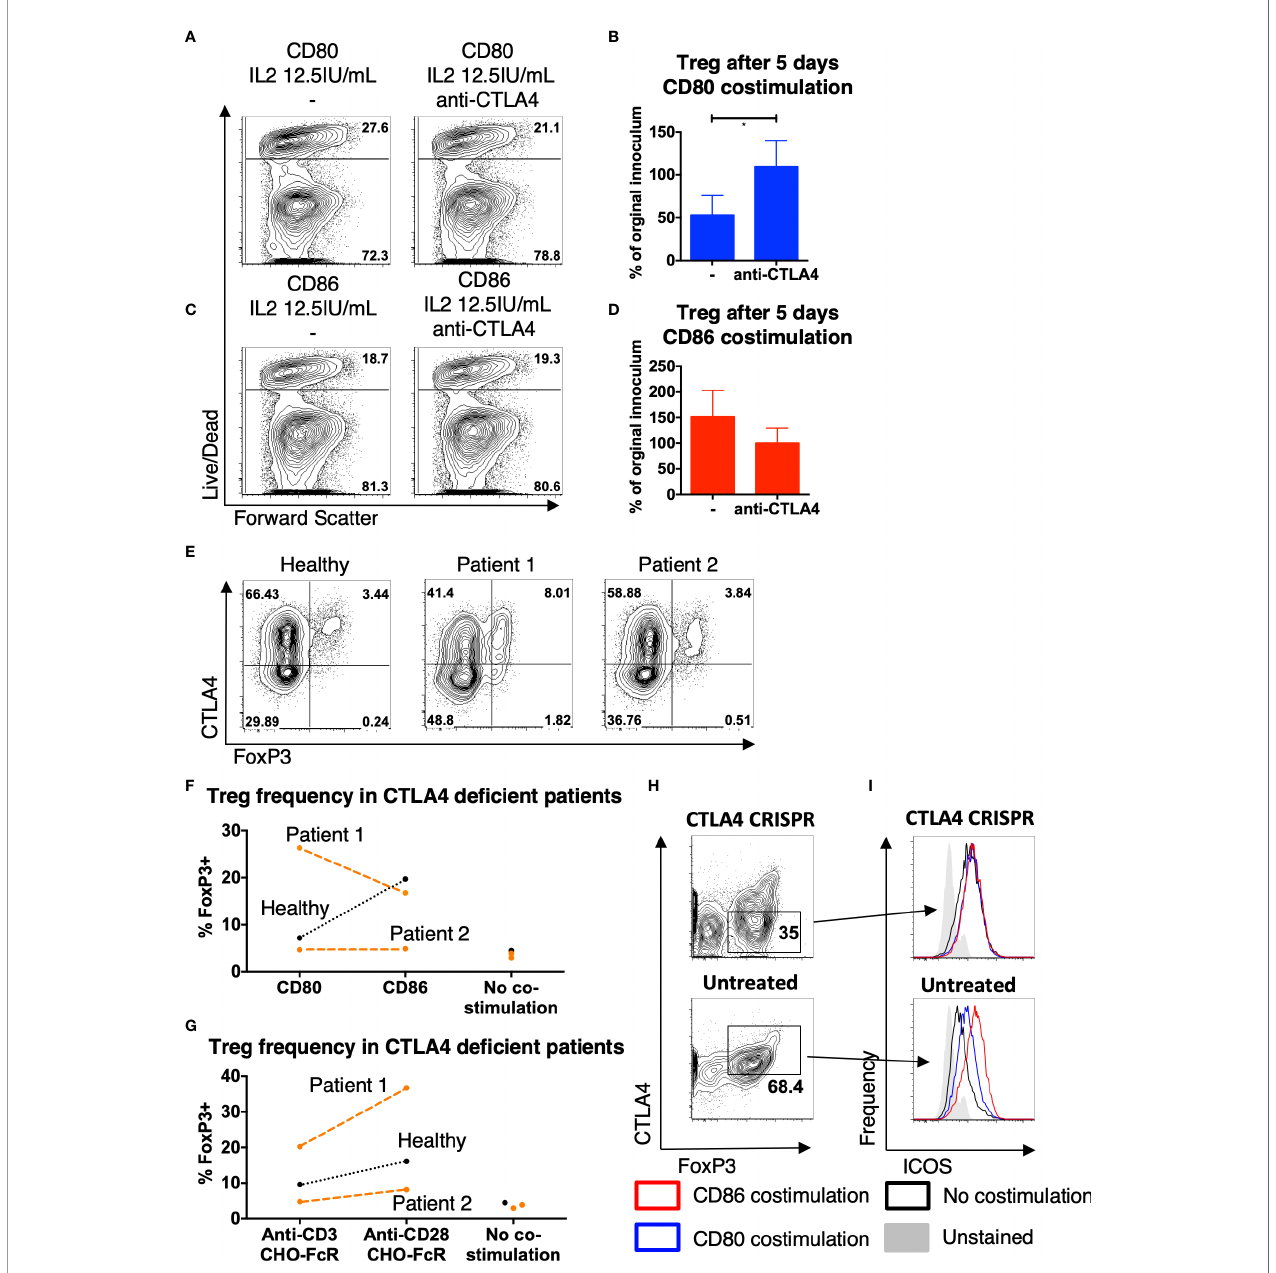
FIGURE 6 | CTLA4 prevents Treg from receiving costimulation from CD80. Puri fi ed Treg isolated from healthy donors were cultured with CHO-CD80, CHO-D86, at 10:1 ratio for 5 days, with 0.5 m g/ml anti-human-CD3 and 12.5 IU/ml IL2 with anti-CTLA4 antibody. (A, B) cytometry plots demonstrate survival of Treg following costimulation with CD80 with- and without anti-CTLA4 antibodies and (C, D) similarly with CD86 costimulation. Representative plots and aggregate data from four independent experiments. (E) Total memory CD4 T cells were isolated from a healthy donor, a patient with LRBA de fi ciency (patient 1) and a patient CTLA4 de fi ciency (patient 2). T cells were stimulated for 16 h with 2:1 T cells: anti-CD3 and anti-CD28 coated activator beads and CTLA4 and FoxP3 expression assessed by fl ow cytometry, demonstrating CTLA4 de fi ciency in both CD4+FoxP3+ and CD4+FoxP3- T cells. (F, G) CTV labeled total memory CD4 T cells, isolated from patients 1 and 2 and a healthy donor, were stimulated at 10:1 ratio with CHO-CD80, CHO-CD86, or untransduced CHO (no costimulation) with 0.5 m g/ml anti- human-CD3 (F) , or at 2.5:1 with CHO-FcR and 1 m g/ml anti-human-CD3 or anti-human-CD28 antibodies (G) for 5 days. Graphs illustrate the frequency of FoxP3+ cells among the divided CD4 T cells. (H, I) Treg were puri fi ed from healthy donors and underwent CTLA-4 deletion by CRISPR and were then cultured 10:1 with CHO-CD80, CHO-CD86, or untransduced CHO (no costimulation) and 0.5 m g/ml anti-human-CD3 for 5 days. (H) demonstrates CTLA4 levels in CRISPR/Cas9 treated and untreated cells after 5 days costimulation. (I) Histograms demonstrating ICOS levels following either CD86 or CD80 costimulation of CTLA4-deleted or untreated, CTLA4-replete Treg (representative plot of two independent experiments). Paired t-test: *p ≤